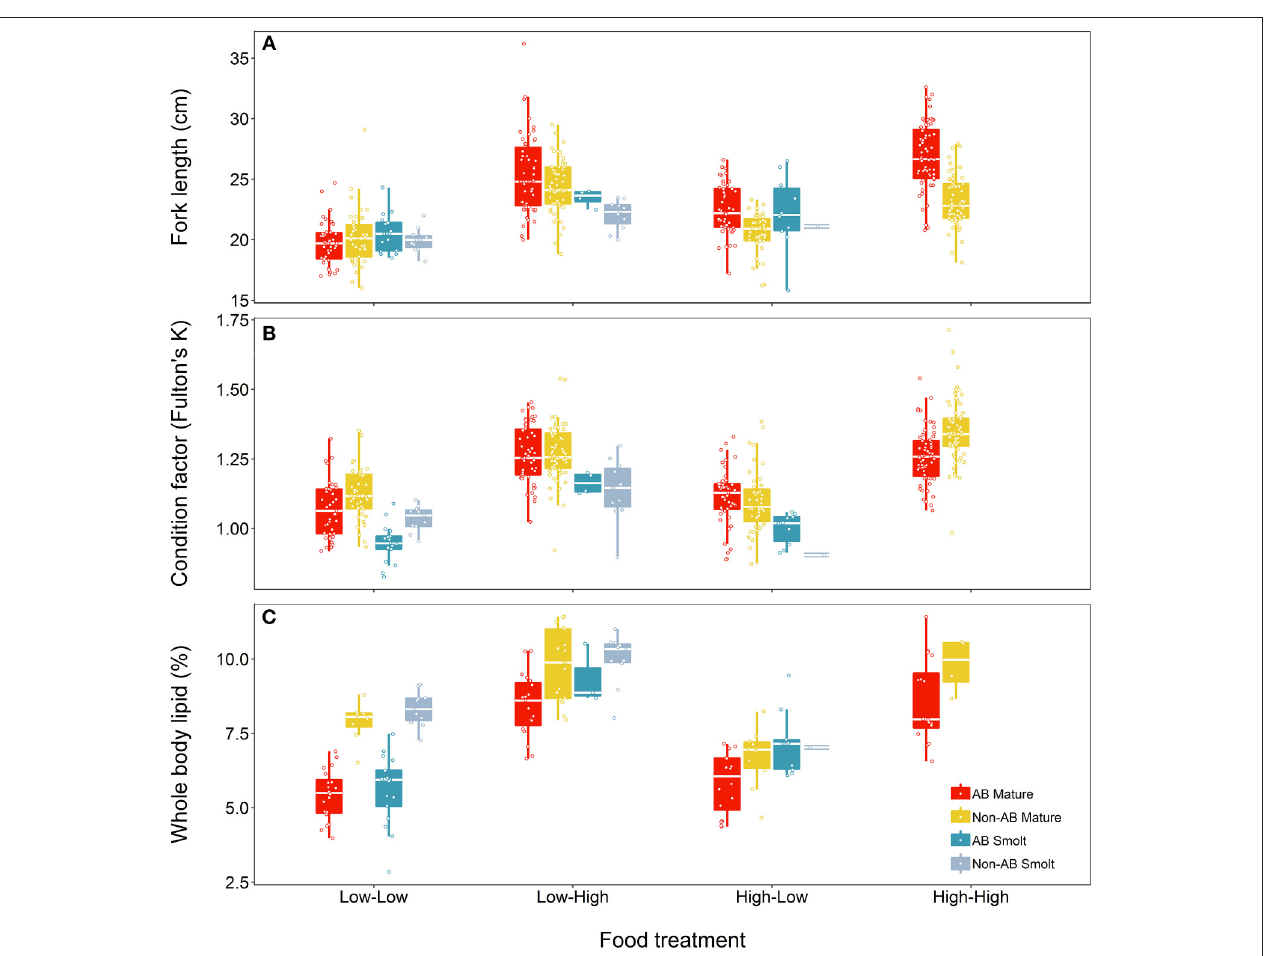
FIGURE 4 | Effects of food treatment on final (A) length, (B) condition factor ( K ), and (C) whole body lipids at the end of the experimental study (Spring 2018) of brown trout offspring classed as either smolts (migratory) or freshwater maturing (non-migratory/resident). Offspring were derived from wild-caught parents from an anadromous-background population (AB) and a non-anadromous-background population (non-AB). The median is represented by the white horizontal lines in each box.